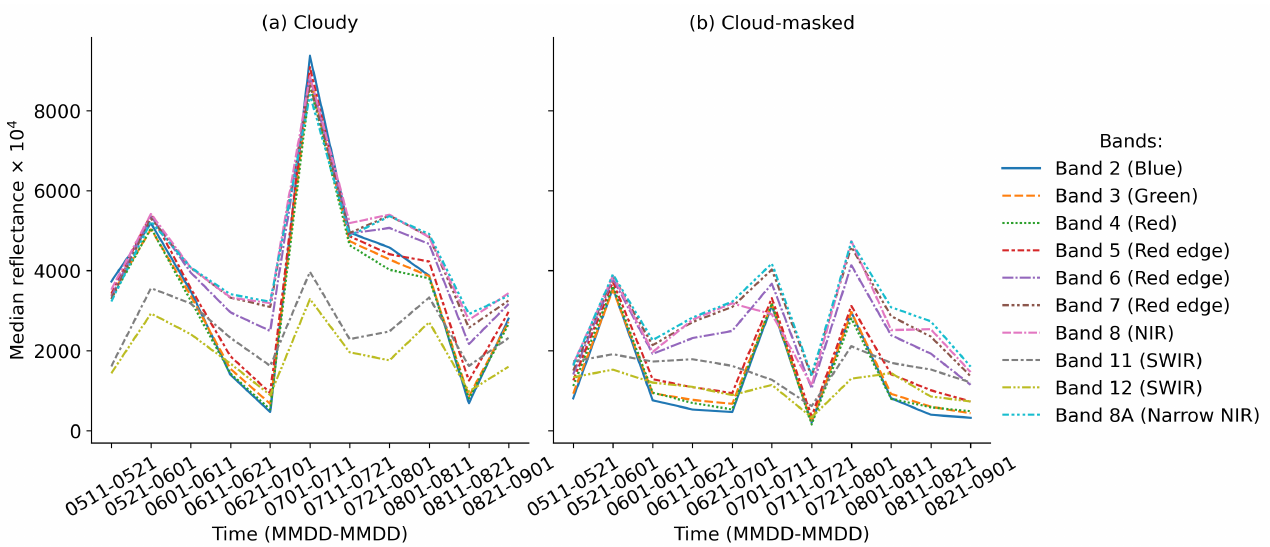
Figure 8. Median values of 10 Sentinel-2 bands from spring wheat fields of a farm as 11-day mean composites. Calculated from ( a ) cloudy and ( b ) cloud-masked surface reflectance. X-axis shows the 12 time windows from a growing